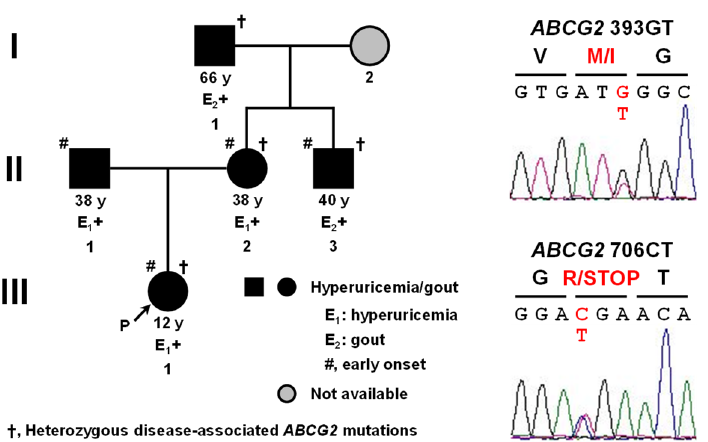
Figure 1. Identification of novel disease-associated mutations c.393G>T (p.M131I) and c.706C>T (p.R236X) in ABCG2 . Left, the pedigree of a Czech family with early-onset hyperuricemia and gout; Right, representative electropherograms of partial sequences of ABCG2 showing the heterozygous point mutations (red) discovered in our present study. I–III, generation of the family; P, proband; y, years old.